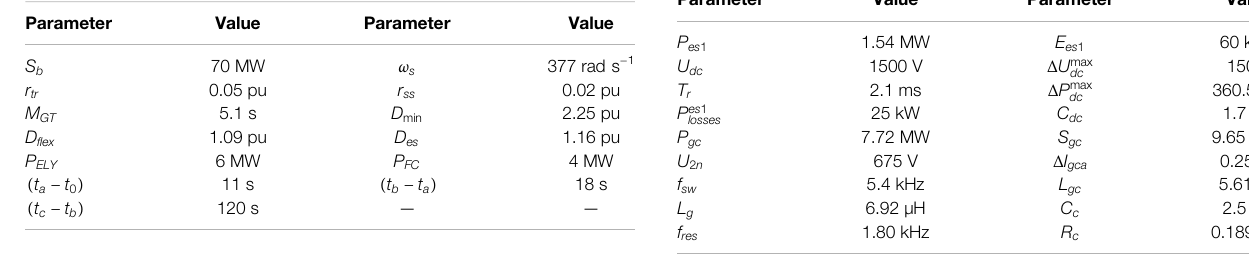
TABLE 1 | Parameters of the ACPS of an offshore oil and gas platform in the Norwegian continental shelf and the requirements for its converter- interfaced ESS.